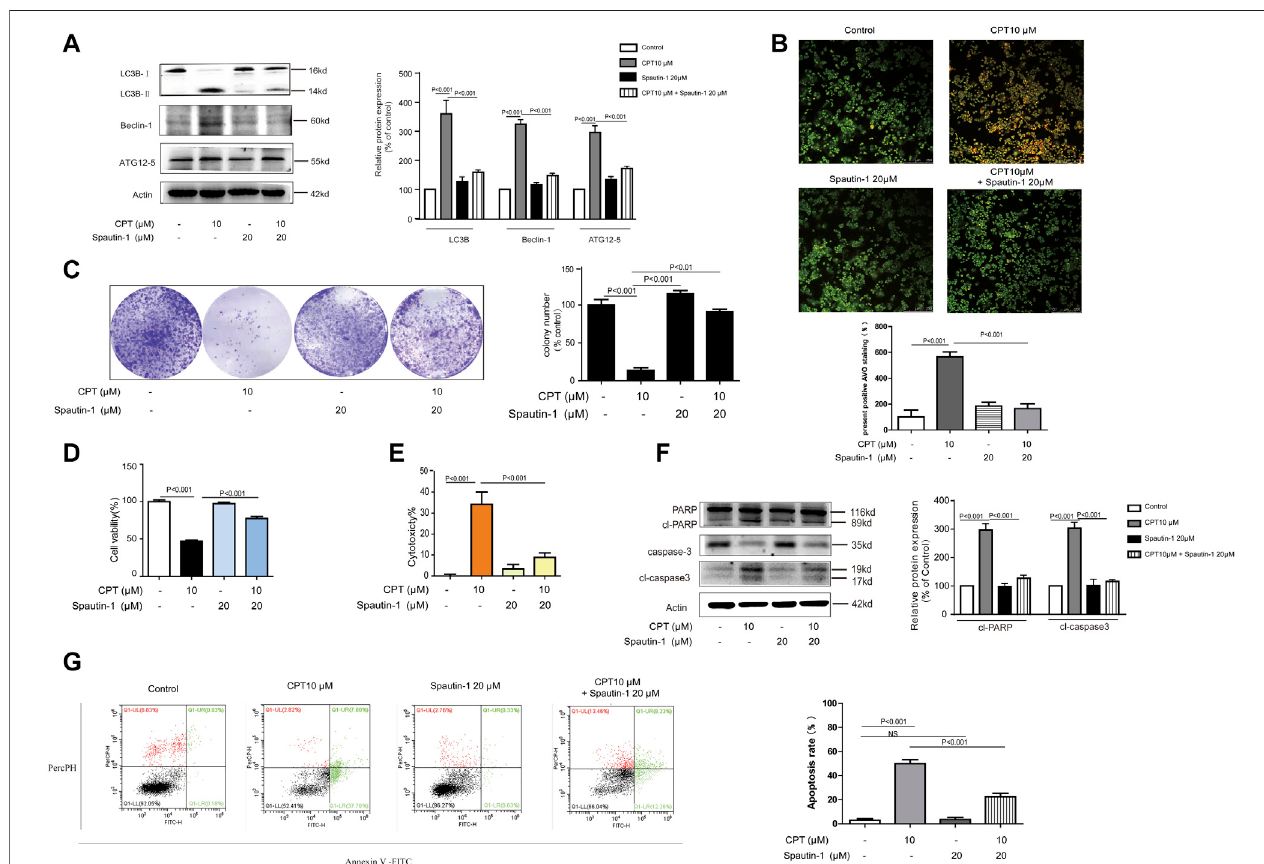
FIGURE5| CPTcaninduceautophagy-mediatedapoptosisinCRCcells.HCT116cellsweretreatedwithorwithoutCPT(10 μ M)for48 hinculturemediuminthe presence or absence of spautin-1 (20 μ M). The expression of autophagy-related proteins (ATG12 – 5, Beclin-1, LC3B) in cell lysate was measured by western blot (A) . Fluorescence microscopy (200 × ) following AO staining detected the number of autophagosomes in HCT116 cells treated as in (A), and quantitative analysis was performed by ImageJ (B) . In the presence or absence of spautin-1 (20 μ M), the colony formation assay of HCT116 cells treated with or without 10 μ M CPT was performed, and the left image was representative and the right image was quantitative (C) . MTT assay (D) , and LDH release (E) assay were used to determine HCT116 cells treated as in (C) . Caspase-3 and PARP in HCT116 cells treated as in (A) were analyzed by western blotting assay and quantitatively analyzed by ImageJ (F) . Apoptosis of HCT116 cells treated as in (C) was quanti fi ed by fl ow cytometry (G) . CPT, cryptotanshinone; LDH, lactate dehydrogenase; CRC, colorectal cancer; AO, acridine orang.